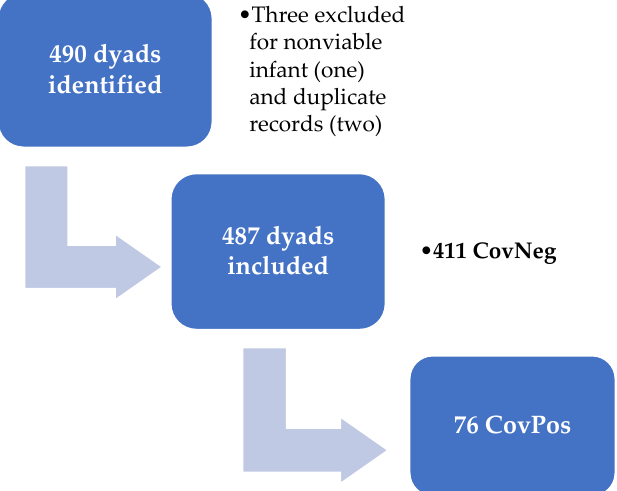
Figure 1. Identification of participants for inclusion.